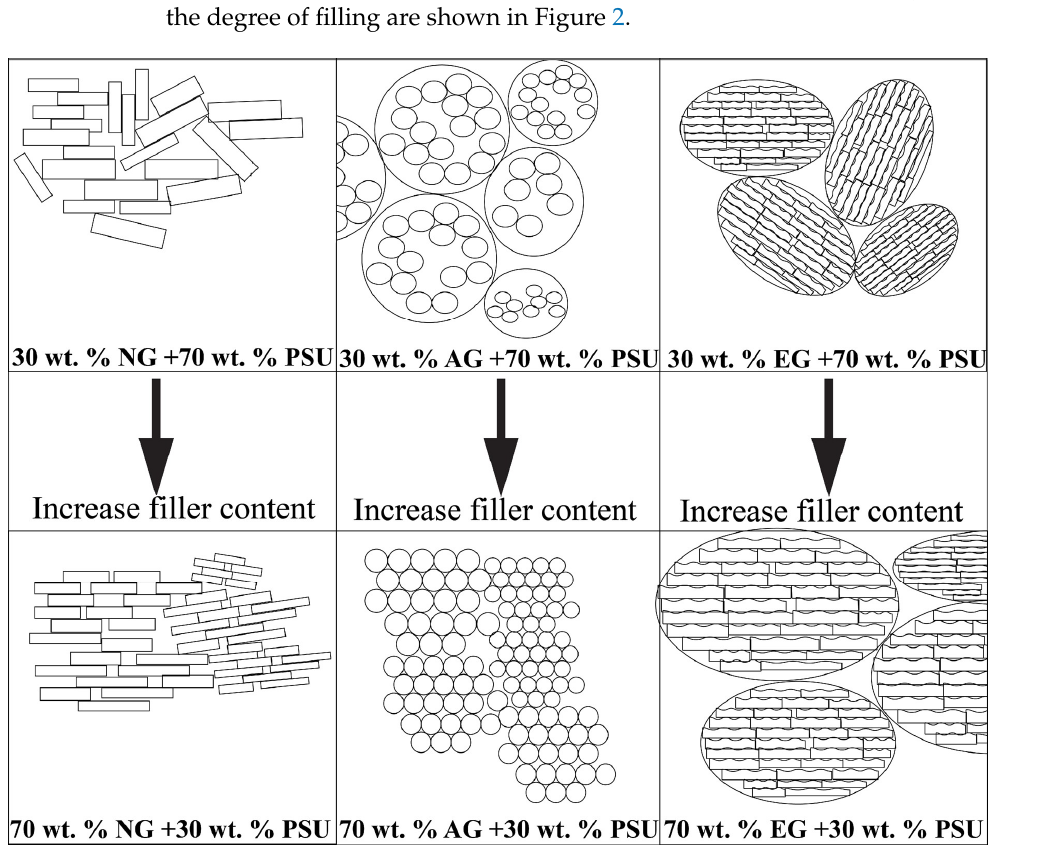
Figure 2. The changes in a composite’s form as the filler content is increased.